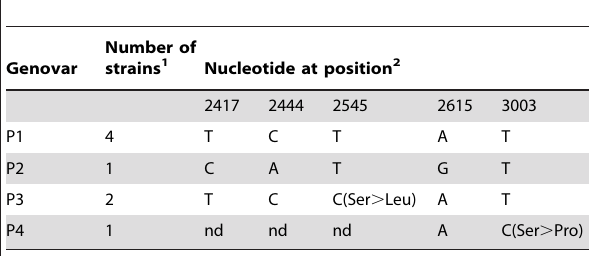
Table 6. Variable nucleotide positions and genovar definition based on the pur A gene of 8 human and tickborne isolates of B. persica in Israel and the West